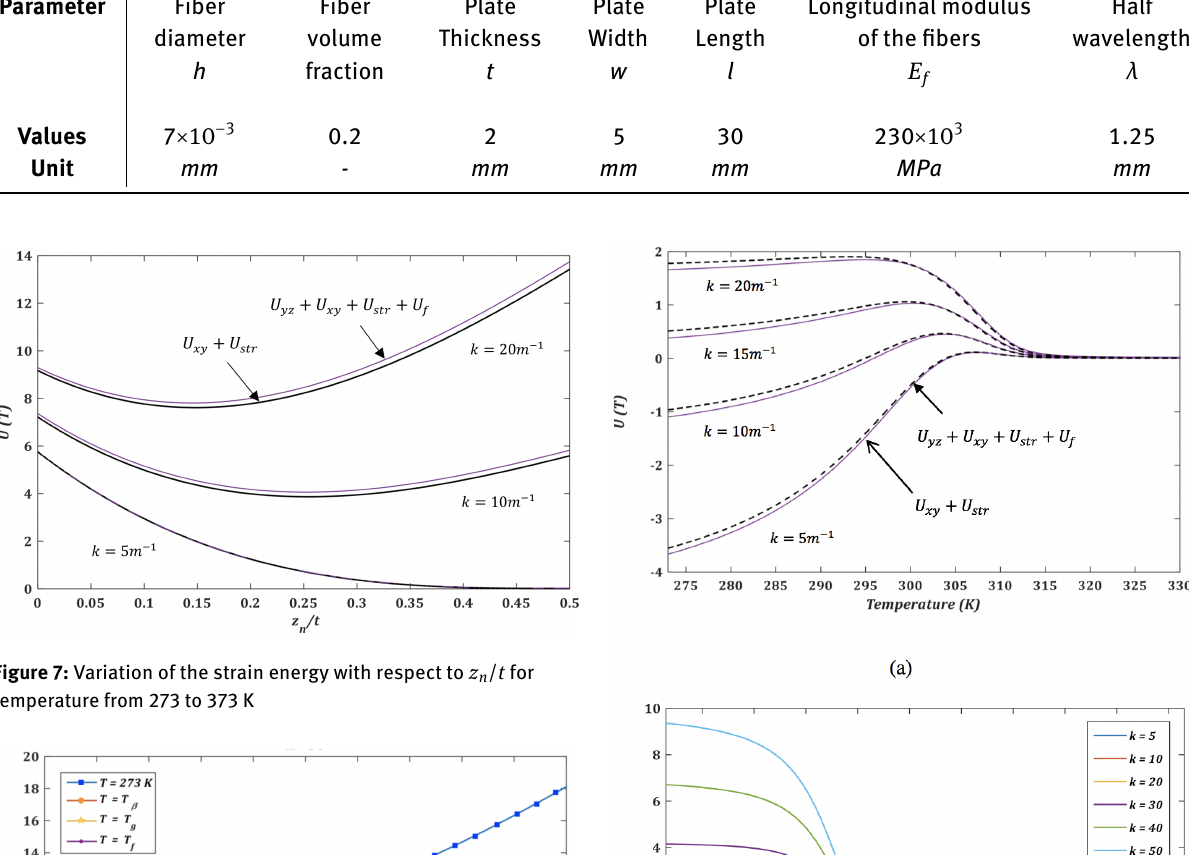
Table 2: Values of the parameters used to model the micro-buckling of the fibers in the SMPC at elevated temperature [31] Parameter